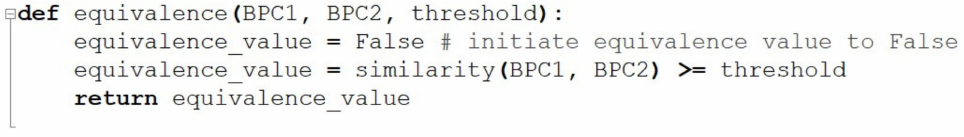
Figure 7. Method for estimating the equivalence between two Business Process